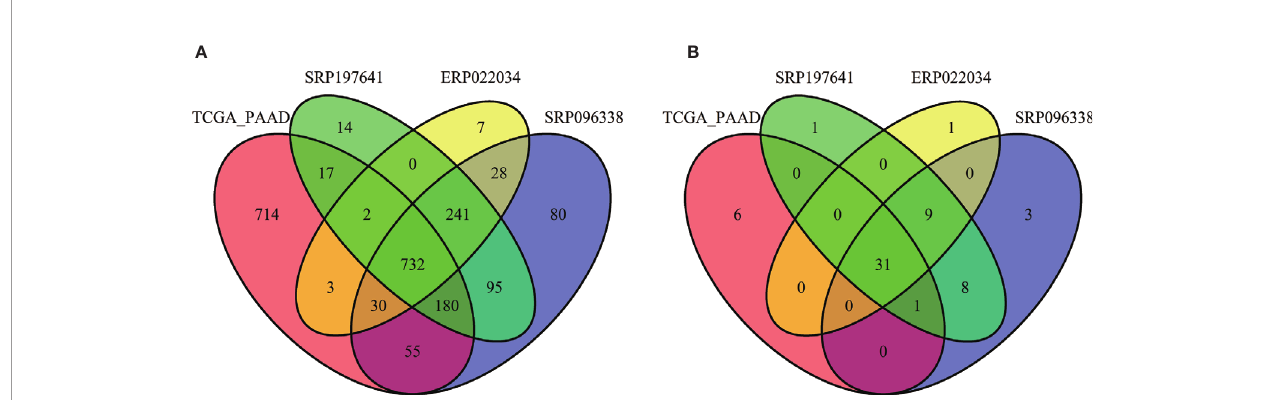
FIGURE 3 | Overlap of the microbial pro fi les across the four datasets at the genus level (A) and at the phylum level (B) .